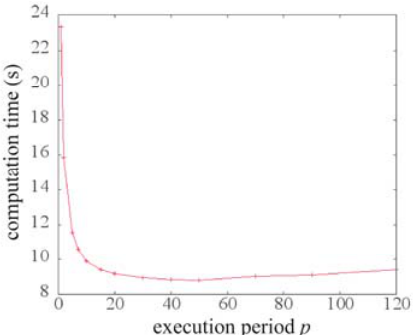
Figure 2: The relation between the execution period for the convolution and the computation time.